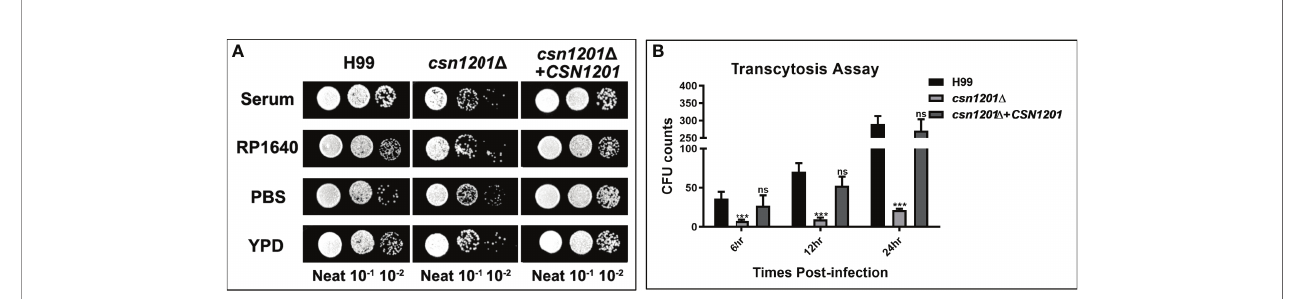
FIGURE 5 | The CSN1201 deletion is involved in serum survival and in vitro blood-brain barrier transcytosis of C. neoformans. (A) . Serum survival assay. Each strain was grown to saturation in YPD at 30°C, diluted 1:10 in mouse serum or YPD, and incubated at 37°C for 4 days. “ Neat ” represents the colony-forming units (CFU) concentration in serum. Strains were serially diluted 10-fold prior to being spotted onto YPD plates. (B) . In vitro transcytosis assay of C. neoformans at 6, 12, and 24 hr. ***, P < 0.001; ns, no signi fi cant